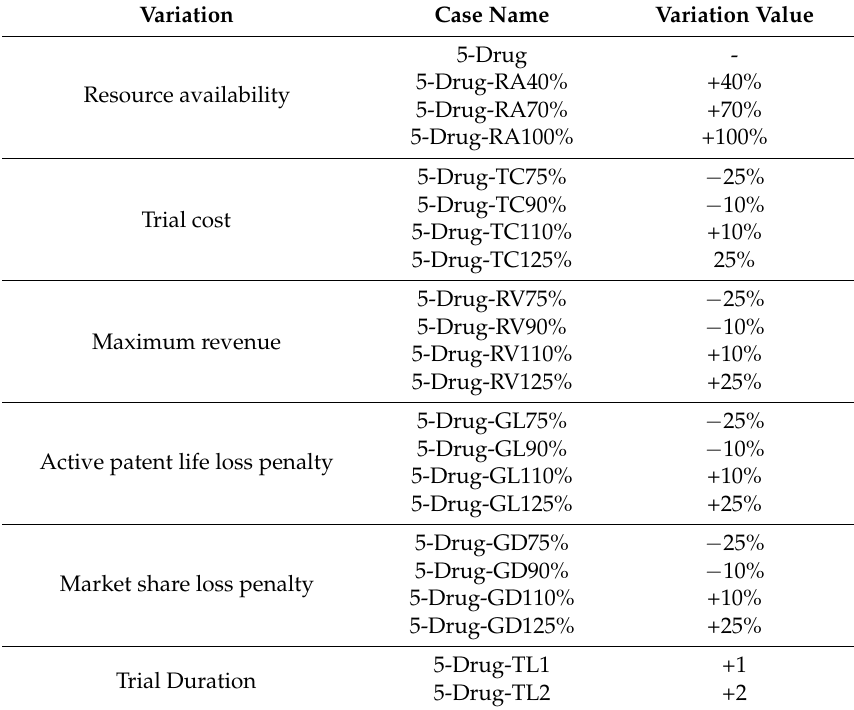
Table 2. Descriptions of case studies used to study the impact of problem parameters on solution times of CM1, CM2 and